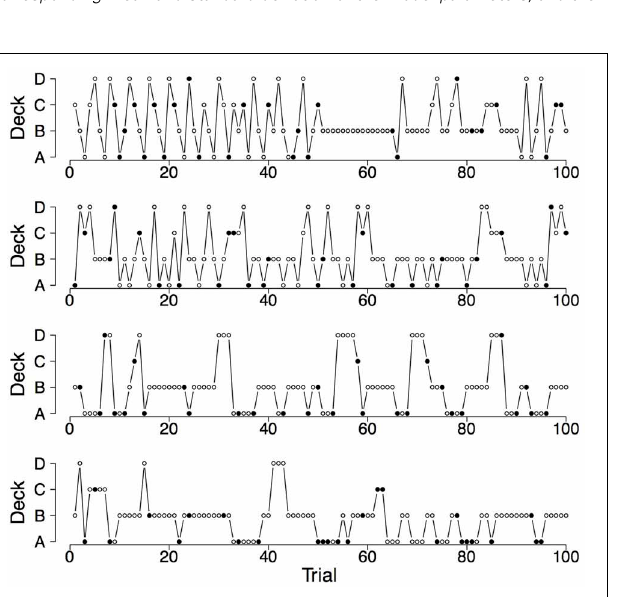
FIGURE 5 | Deck selection profiles of four synthetic participants showing a pronounced preference for the bad decks (generated by